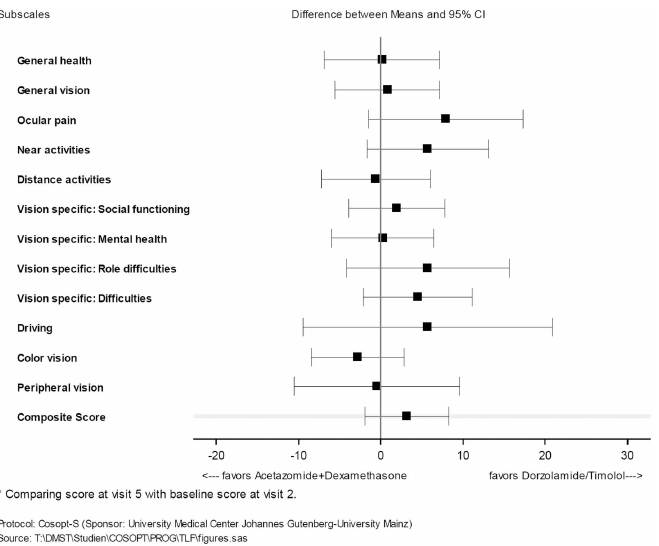
Fig 3. Change of NEI VFQ 25 at visit 5 from baseline (visit 2)–ITT population (n = 62).